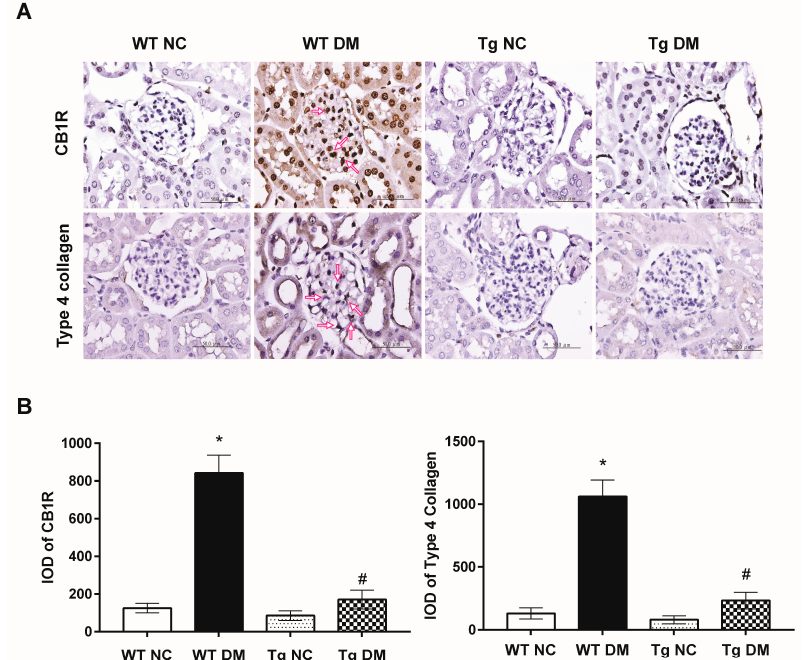
Figure 4. ( A ) Representative images of immunohistochemistry for CB1R and type 4 collagen in renal sections of study animals. Arrows indicate positive staining over mesangial cells or the mesangium. ( B ) The integrated optical density (IOD) of CB1R and type 4 collagen IHC-stained materials were analyzed. Data are presented as means ± standard errors calculated from six independent experiments. The symbol * indicates significant difference vs. the WT NC group ( p < 0.05); the symbol # indicates significant difference vs. the WT DM group ( p < 0.05).